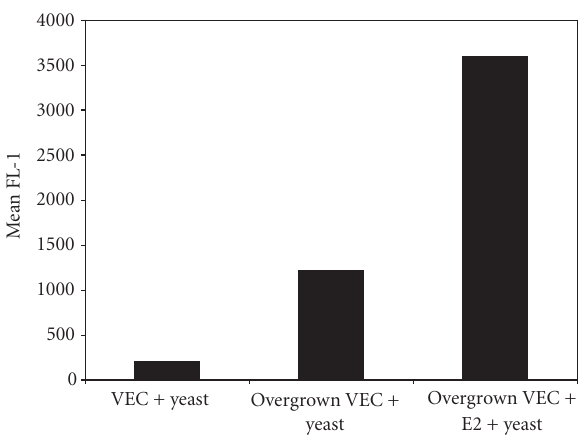
Figure 5: The e ff ect of environmental conditions on yeast adher- ence to VEC. Controls consisted of VEC incubated with fluores- cenced yeast for 30 minutes before analysis. VEC obtained from cul- tures that had grown beyond the time they would ordinarily be har- vested showed greater relative fluorescence than did cells harvested on a normal schedule. VEC undergoing prolonged cultivation in the presence of 1 . 0 × 10 − 9 estradiol (E2) showed the highest level of fluorescence due to fluorescent yeast adherence.